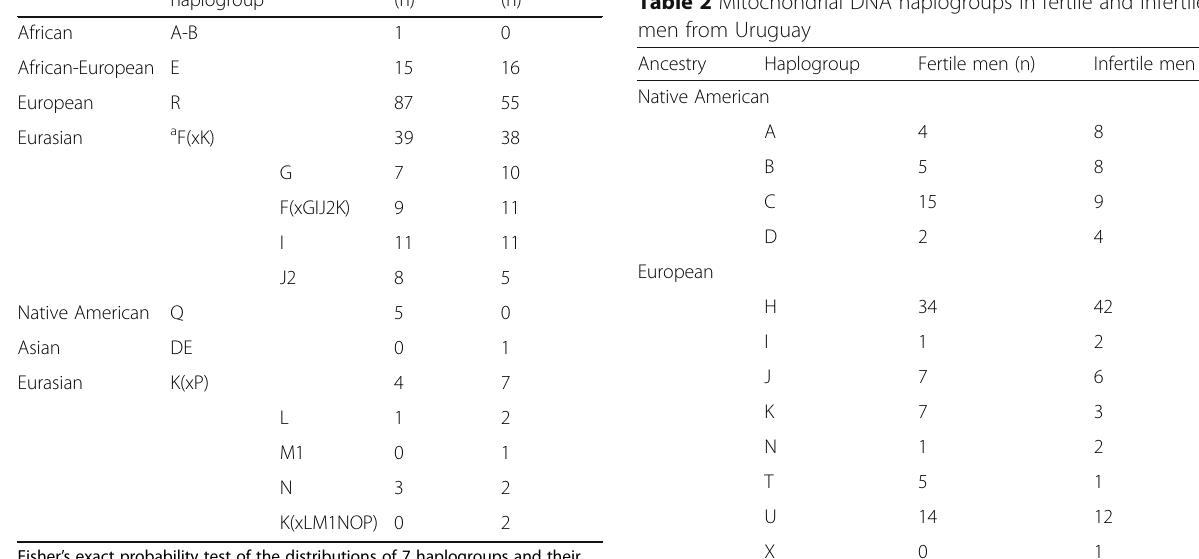
Table 2 Mitochondrial DNA haplogroups in fertile and